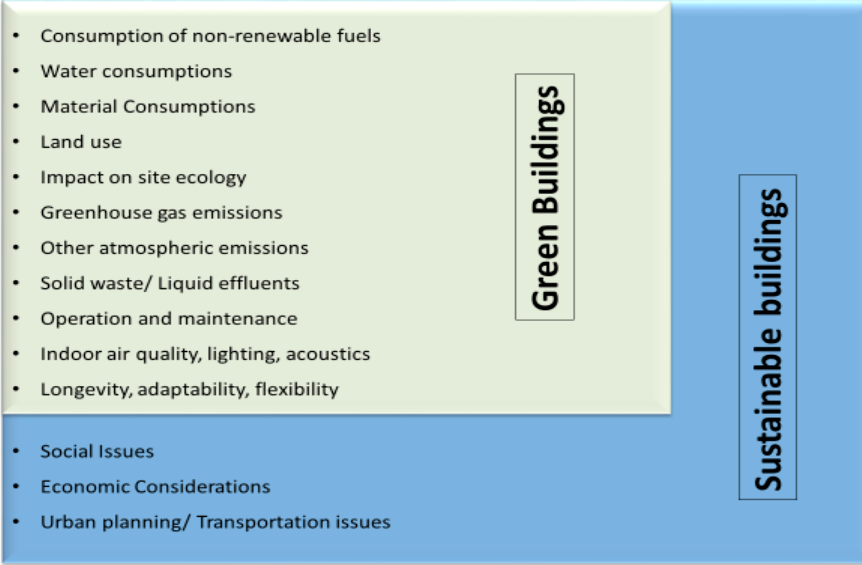
Figure 1. Building performance goal defined by the scope of issues considered (UNEP 2009). The triple bottom line (TBL) concept has been criticized as a limited tool for under- standing sustainable development and covering all underlying issues [43]. To address this limitation, researchers have incorporated more dimensions such as governance and cul- ture [44–47]. Table 2 provides a list of studies that challenge the effectiveness of the triple bottom line and have incorporated one or more dimensions to the existing triple bottom line according to the relevant fields of study. Table 2. List of literature extending the triple bottom line.